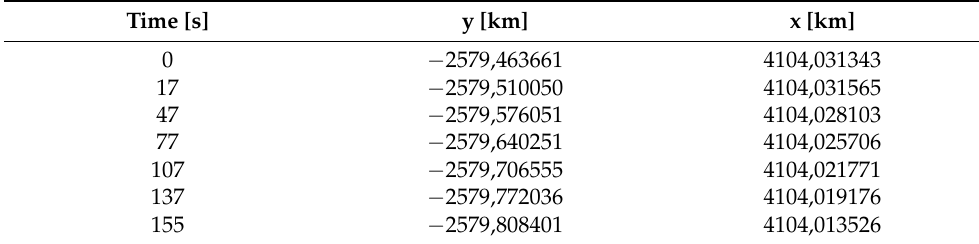
Table 1. x, y coordinates with assigned time.